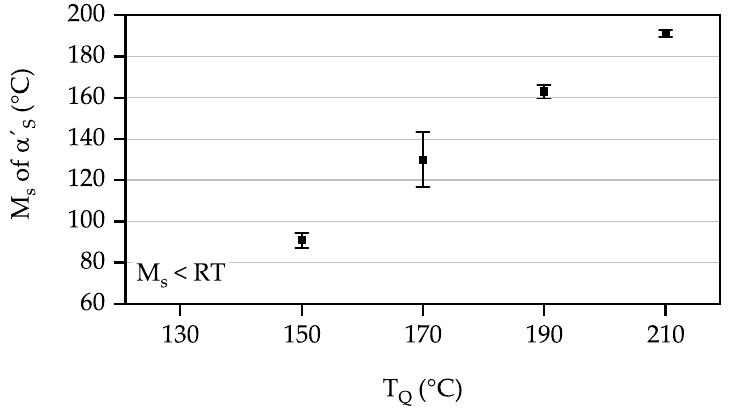
Figure 8. M s of secondary martensite in dependence of T Q